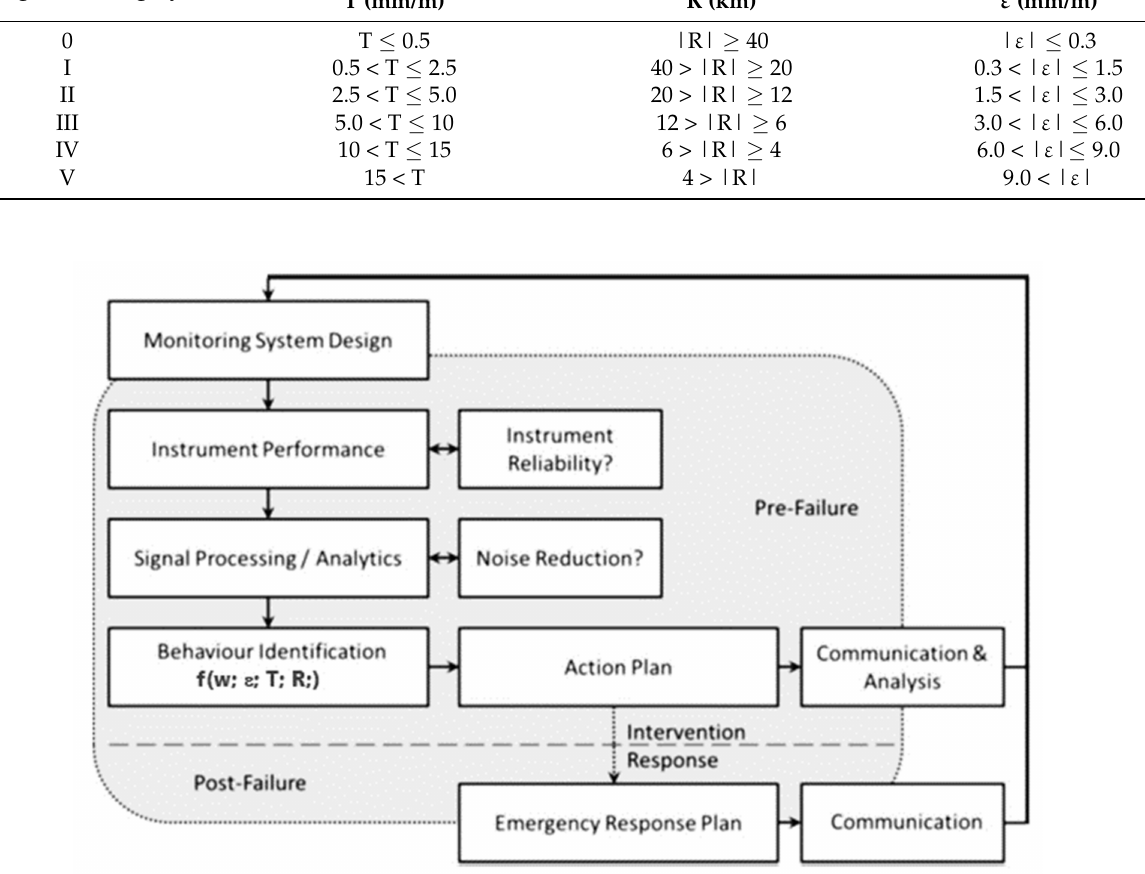
Table 1. Classification of mining areas in the area of continuous deformation indicators of land deformation. Mining Area Category